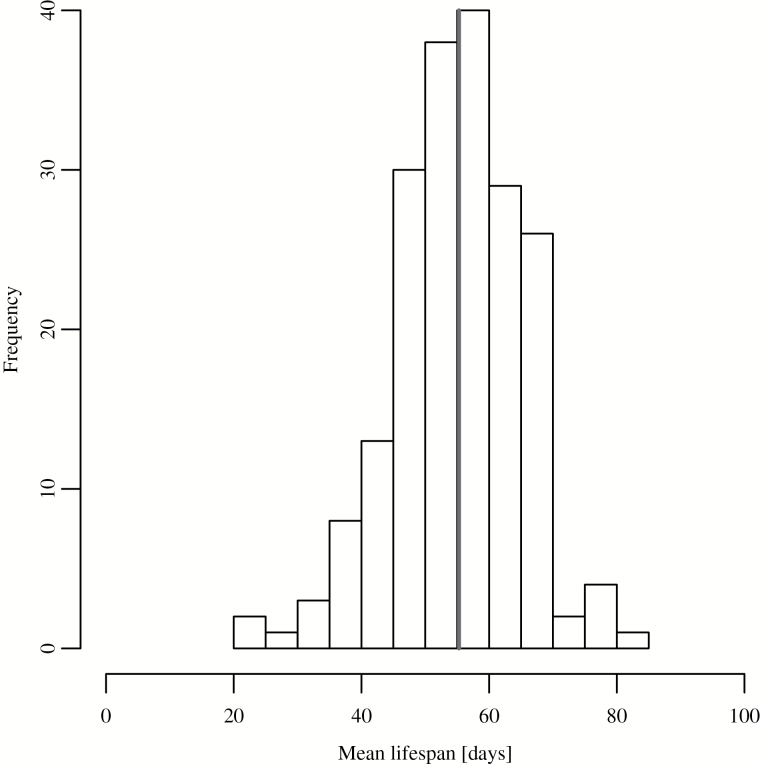
Distribution of lifespan (197 lines). The black vertical line represents the mean lifespan (55.28 days).